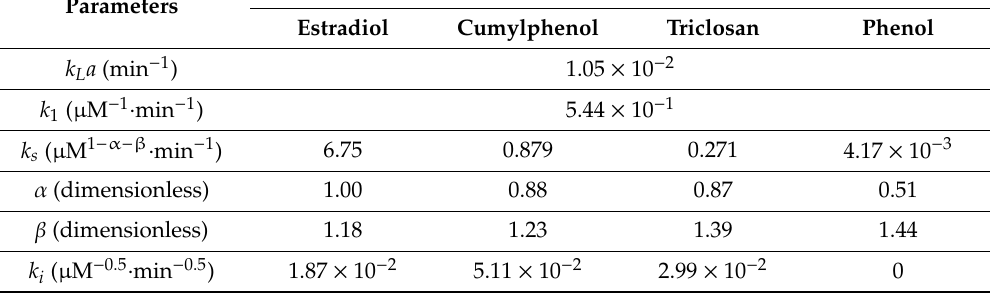
Table A1. Modeled average rates of substrate oxidation (and relative rates with respect to phenol) during the first minute of reactions conducted at high and low enzyme concentrations at pH 5.0 and 25 ◦ C. Also shown is the estimated percentage of enzyme inactivated over the first minute of the reaction modeled under conditions of high substrate and high enzyme concentrations where inactivation would be greatest. Parameter Values Used to Model Substrate Parameters